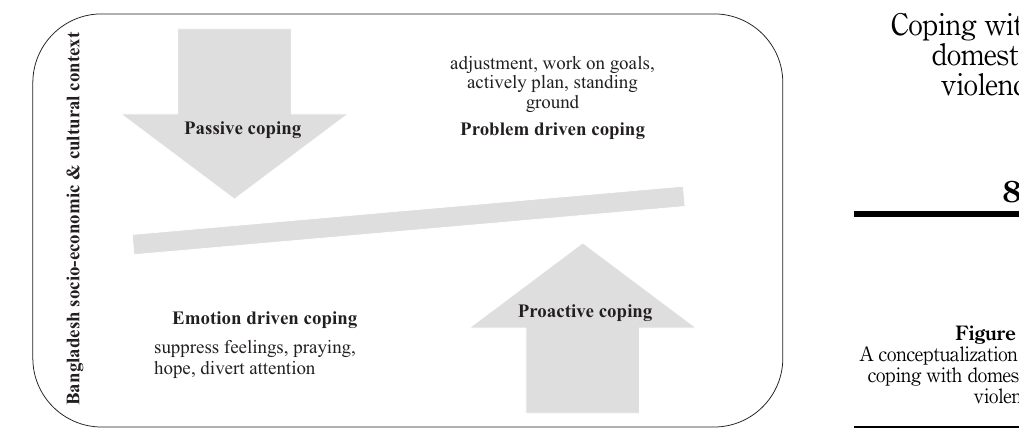
Figure 1. A conceptualization